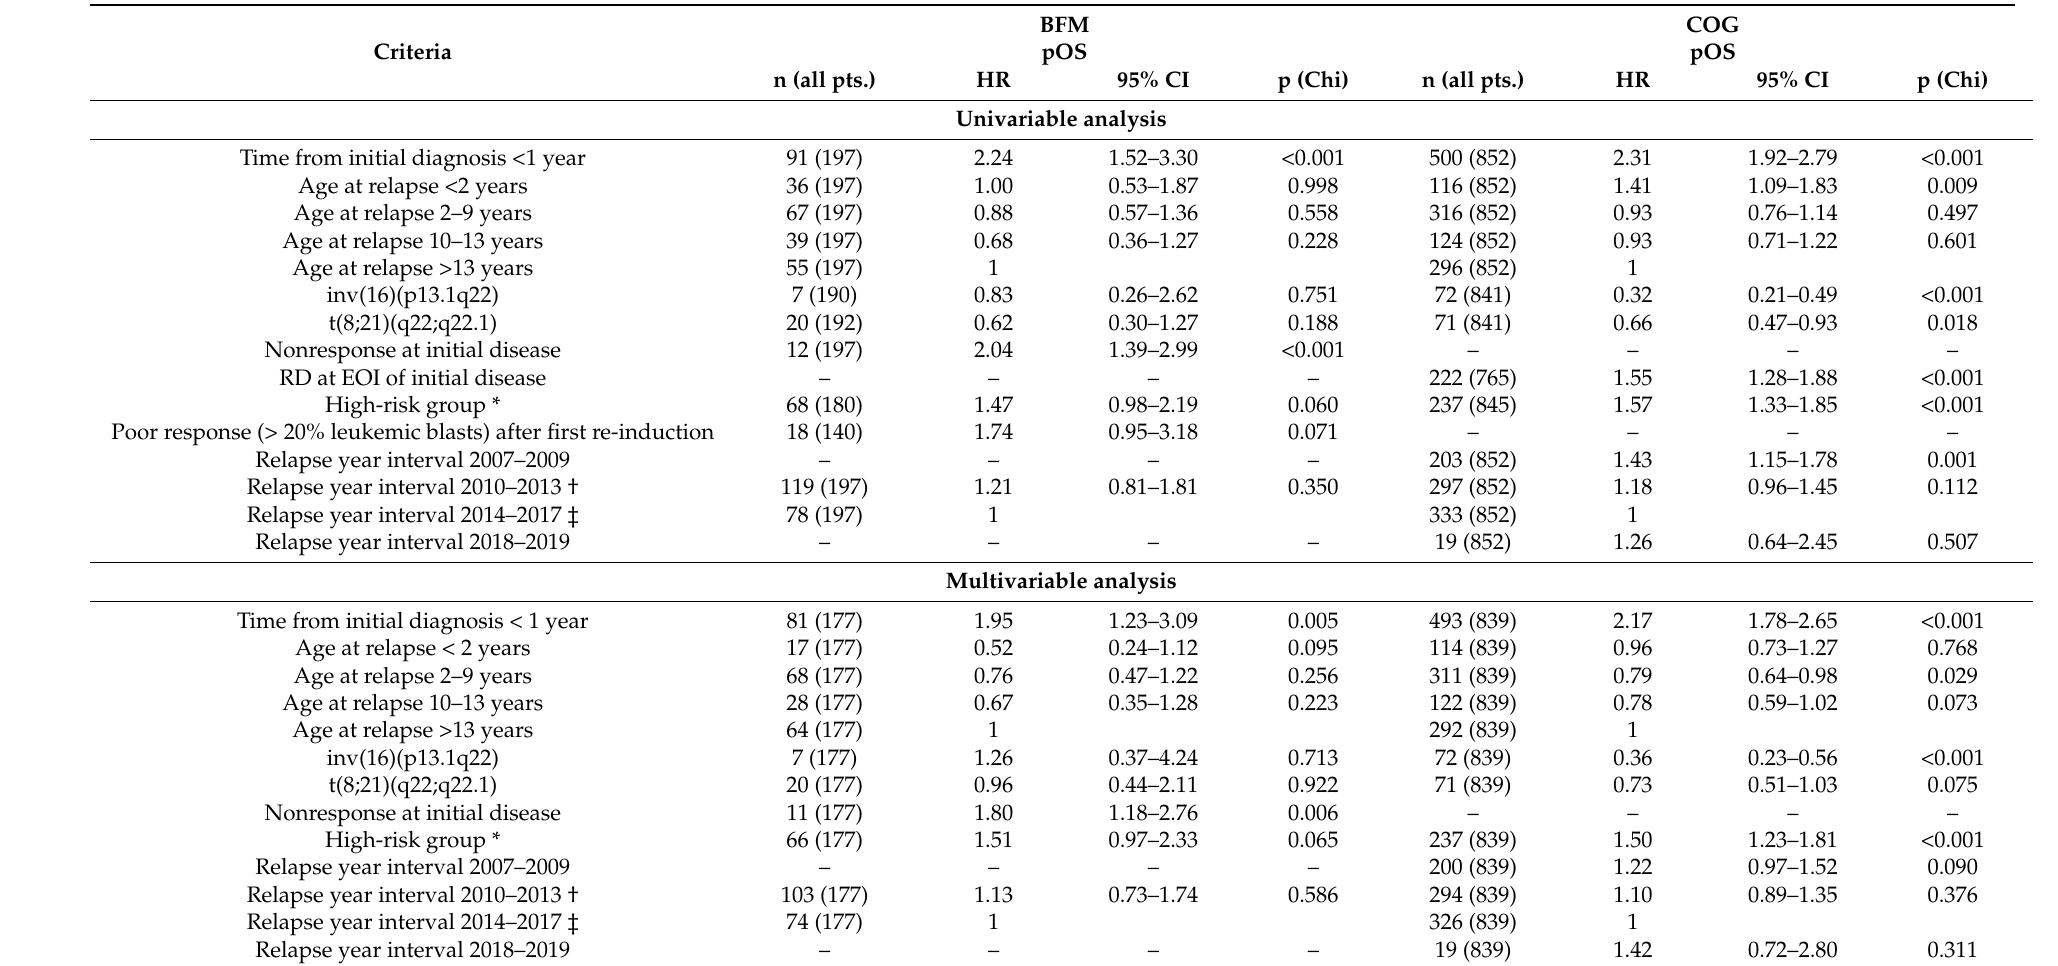
Table legend: Abbreviations: Chi, Chi-square test; CI, confidence interval; EOI, end of induction; HR, hazard ratio; pts, patients; RD, residual disease detected by central flow cytometry. * Retrospective risk classification according to Table S1 including genetic and response criteria for the BFM cohort and genetic and RD criteria for the COG cohort (AAML1031 definition). † This interval includes patients from 04/2009 until 07/2013 for the BFM cohort. ‡ This interval includes patients from 08/2013 until 2017 for the BFM